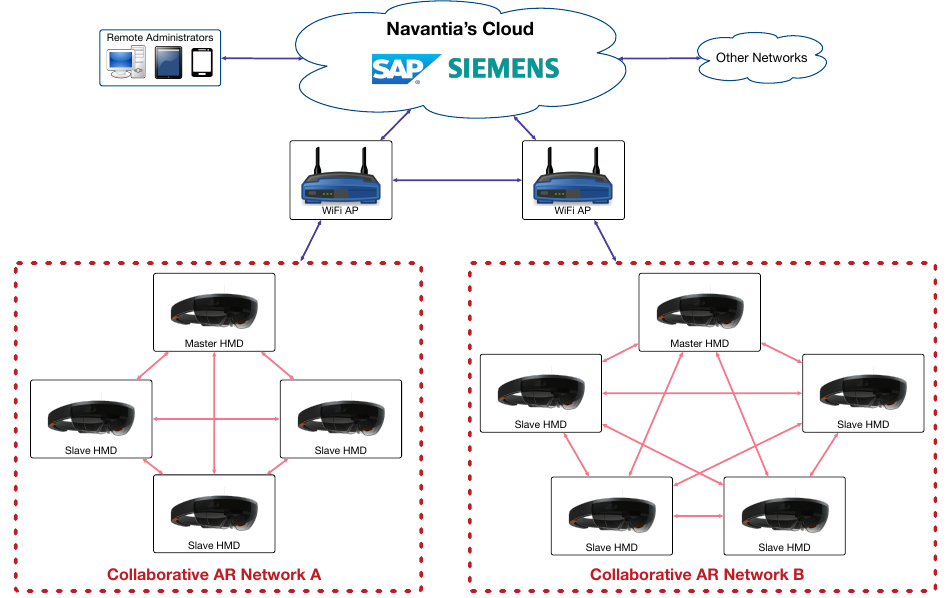
Figure 1. Architecture of the proposed collaborative AR